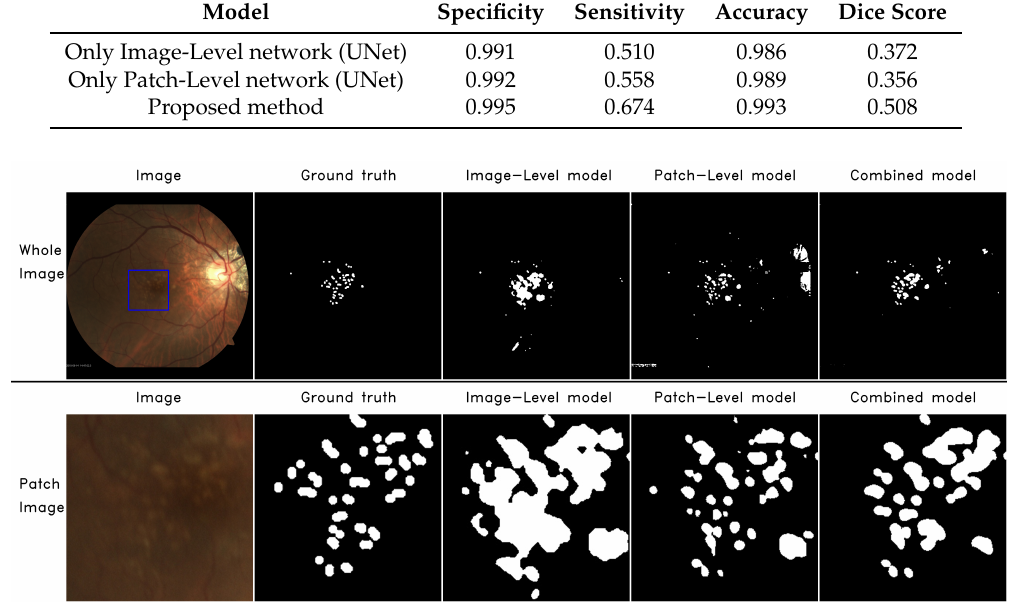
Figure 5. The segmentation results of Image-Level model, Patch-Level model, and combined model.